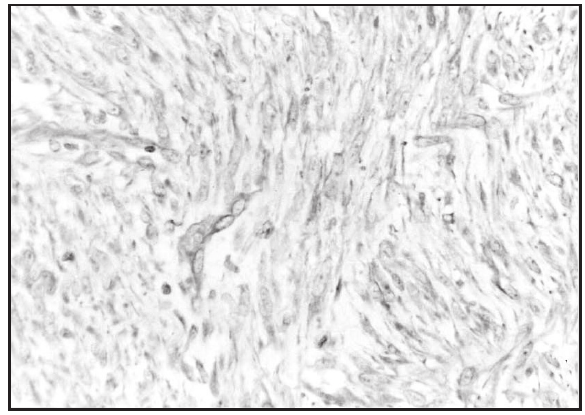
Figura 7 – Caso 1/vimentina. Todas as células neoplásicas exibindo marcação fortemente positiva para o anticorpo (100x)